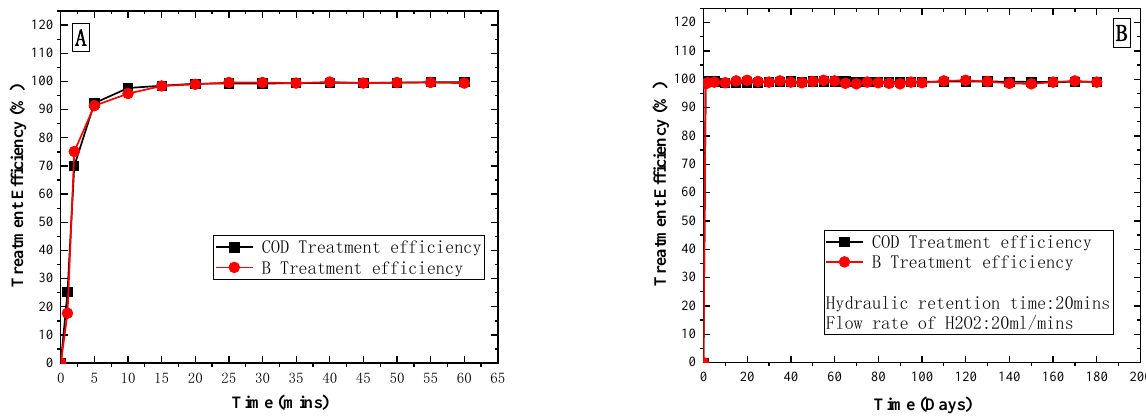
Figure 7. The treatment efficiency curve of real factory modular device. ( A ) COD and Boron treatment efficiency with H 2 O 2 ( B ) COD and Boron treatment efficiency at 180